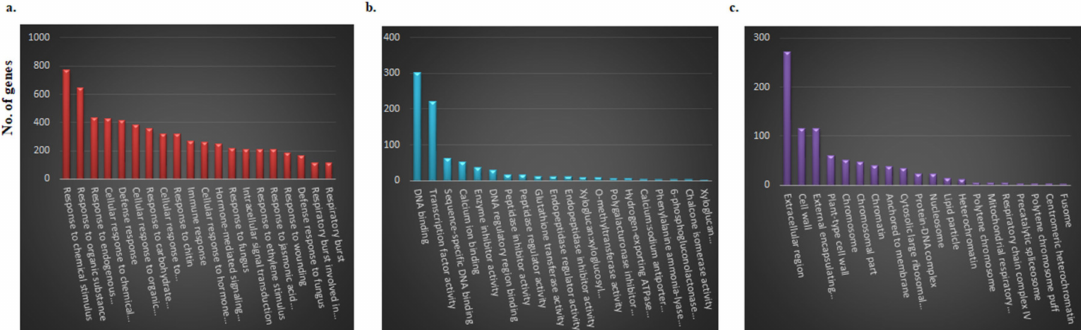
Figure 3. Gene ontology (GO) analysis of di ff erentially expressed genes (DEGs) between red and green Chinese cabbage. DEGs were grouped into three categories: ( a ) Biological process; ( b ) molecular function; and ( c ) cellular component. X-axis shows gene annotation term; y-axis shows number of